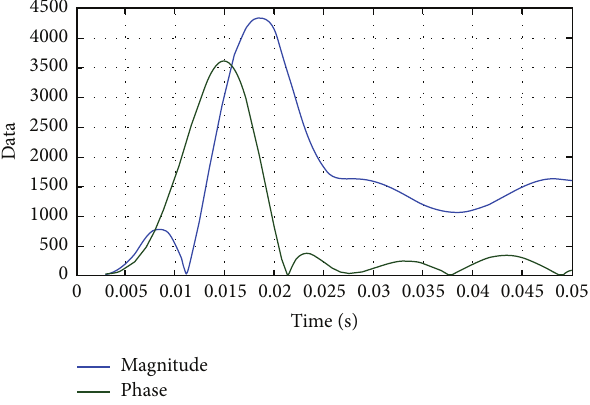
Figure 21: Magnitude and phase of power